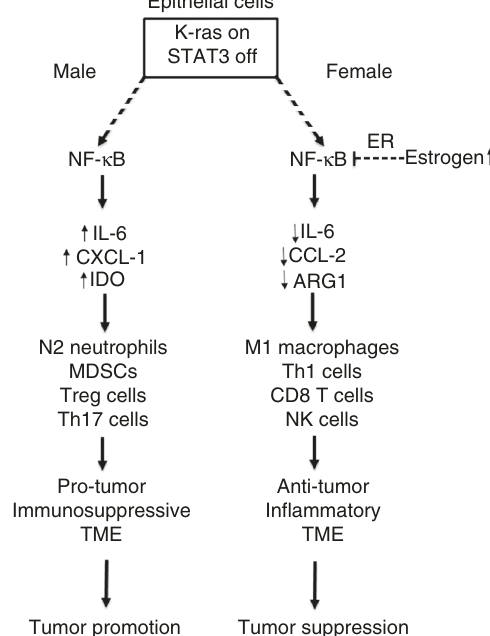
Fig. 7 Mechanisms underlying sex-associated function of epithelial STAT3 signaling in K-ras mutant lung cancer. Our fi ndings suggest that there is a differential regulation of NF- κ B activation in K-ras mutant STAT3- de fi cient lung epithelium within sex, and estrogen signaling plays a protective role in females by reducing the activation of NF- κ B pathway and subsequent induction of an anti-tumor immune response. It also suggests that activation of NF- κ B pathway in the lung of male mice drives the tumor- promoting effect of STAT3 de fi ciency probably by induction of IL-6 and CXCL1, and subsequent recruitment of neutrophils and induction of a